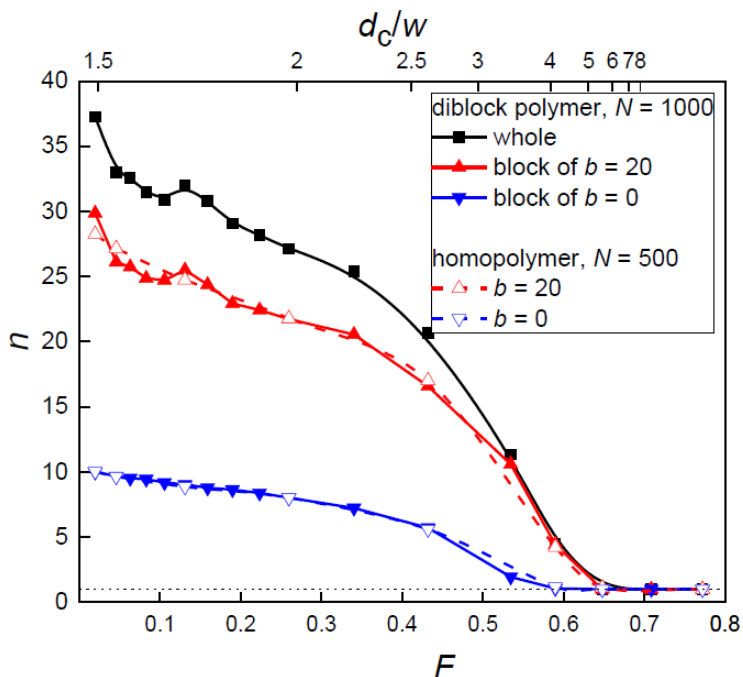
Figure 3. Occupation number n of a diblock chain, its blocks and homopolymer chains corresponding to the blocks as a function of the filling fraction of posts F or the confinement ratio d c / w for constant post separation S p = 12 and varying d p . Values of d p are presented in the corresponding Figure 4. The span behavior of the diblock copolymer in the nanopost array, depicted in Figure 4, represents the axial elongation of the copolymer in the quasi-cylindrical interstitial volumes and reflects also the lateral penetration transition quantified by the occupation number n , shown above in (Figure 3). The overall span monotonically increases and levels off at high F where the diblock chain is stretched along the posts in a single narrow interstitial volume. As the post diameter decreases the interstitial volumes become broader and the chain penetrates into more interstitial volumes. In broader interstitial volumes, a chain has more space to relax in the lateral directions and at the same time, there is also a lateral expansion of a chain over more interstitial volumes. The decrease of span comes also from the fact that on penetration to neighboring interstitial channel-like volumes the chain may follow an opposite direction along the posts. As with the occupation number, the span and the observed transition are mainly governed by the stiffer block. The span of the individual blocks is additive only at a high filling fraction, F ≥ 0.65, where the whole chain resides in a single interstitial volume. At lower F , the additivity does not hold. As in the case of the occupation number, the span of the individual blocks does not differ from the span of the individual homopolymer chain over the whole range of F .